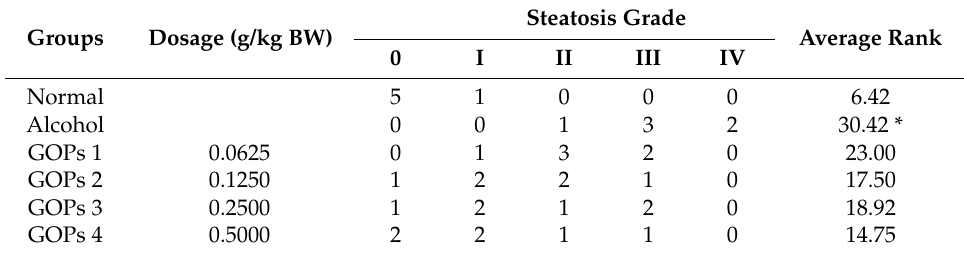
Table 5. Score result of the pathological changes in liver of